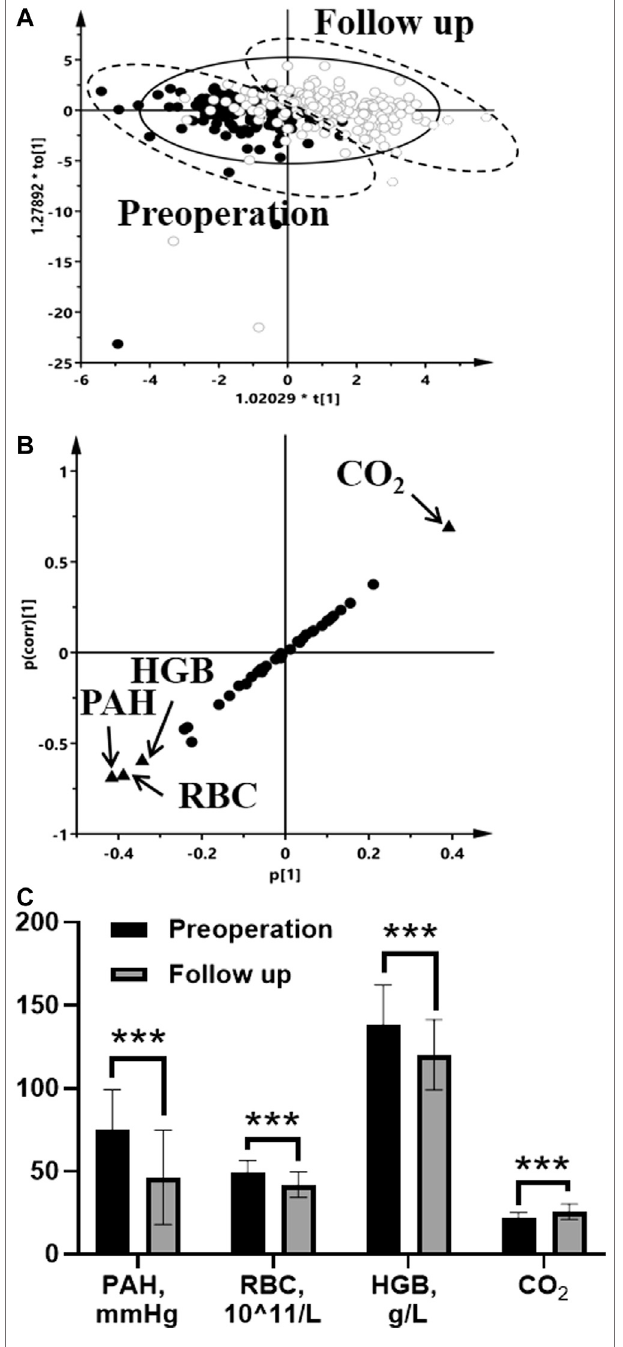
FIGURE1| Indicatorsanalysisinthepreoperativegroupandthefollow-up groupbyOPLS-DAscoreplots (A) ,S-plot (B) ,andcomparisonoffourdifference indicators (C) ( C , the preoperative group inscore plots; ○ , the follow-up group in score plots; four differential indicators are labeled in S-plots). Statistical analysis was performed using t test. * p < 0.05; ** p < 0.01; *** p < 0.001.